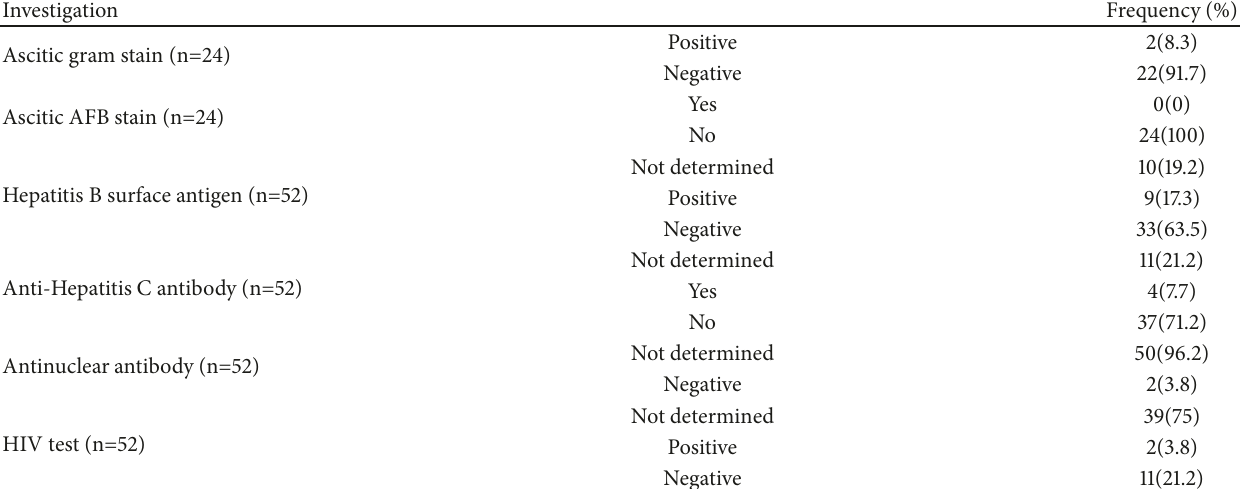
Table 4: Investigation profiles of